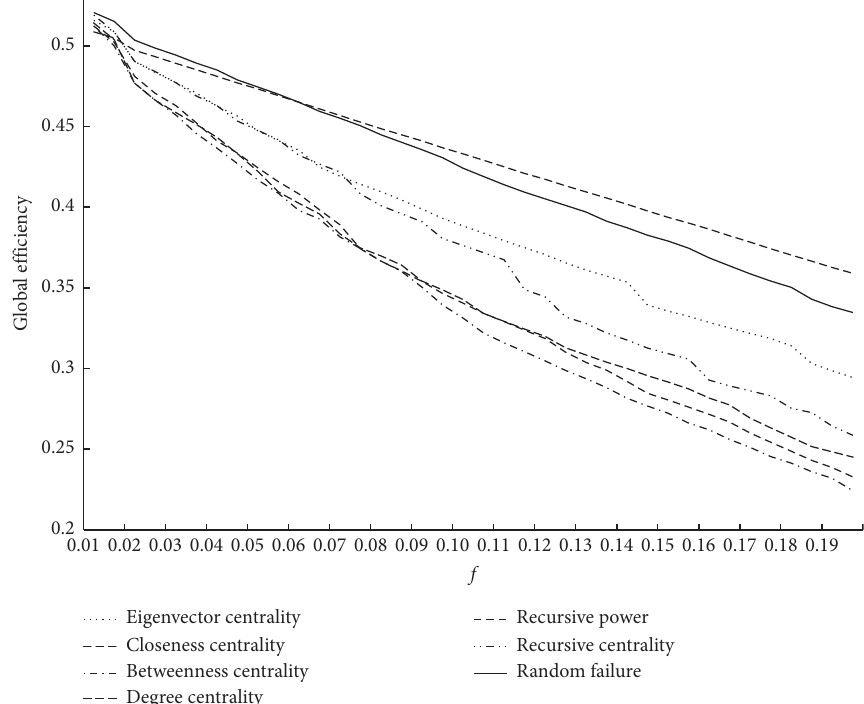
Figure 8: Evolution of global efficiency in unweighted and weighted